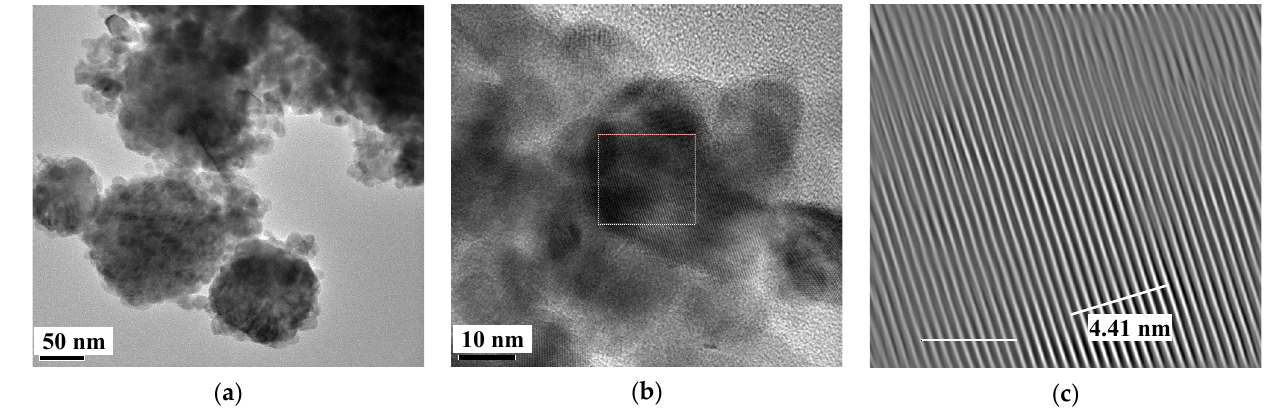
Figure 47. TEM ( a ) and HRTEM ( b , c ) images of NiFe 2 O 4 nanoparticles in sample NA. An enlarged area marked in ( b ) is shown in ( c ). Adapted from Ref. [79] with permission from Elsevier: Materials